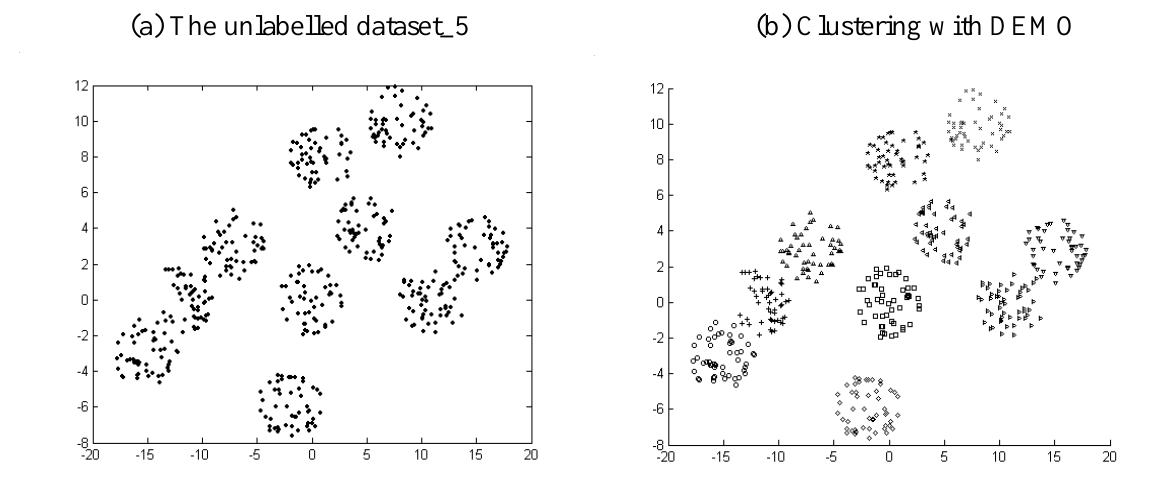
Figure 8. Clustering result for artificial dataset_5.